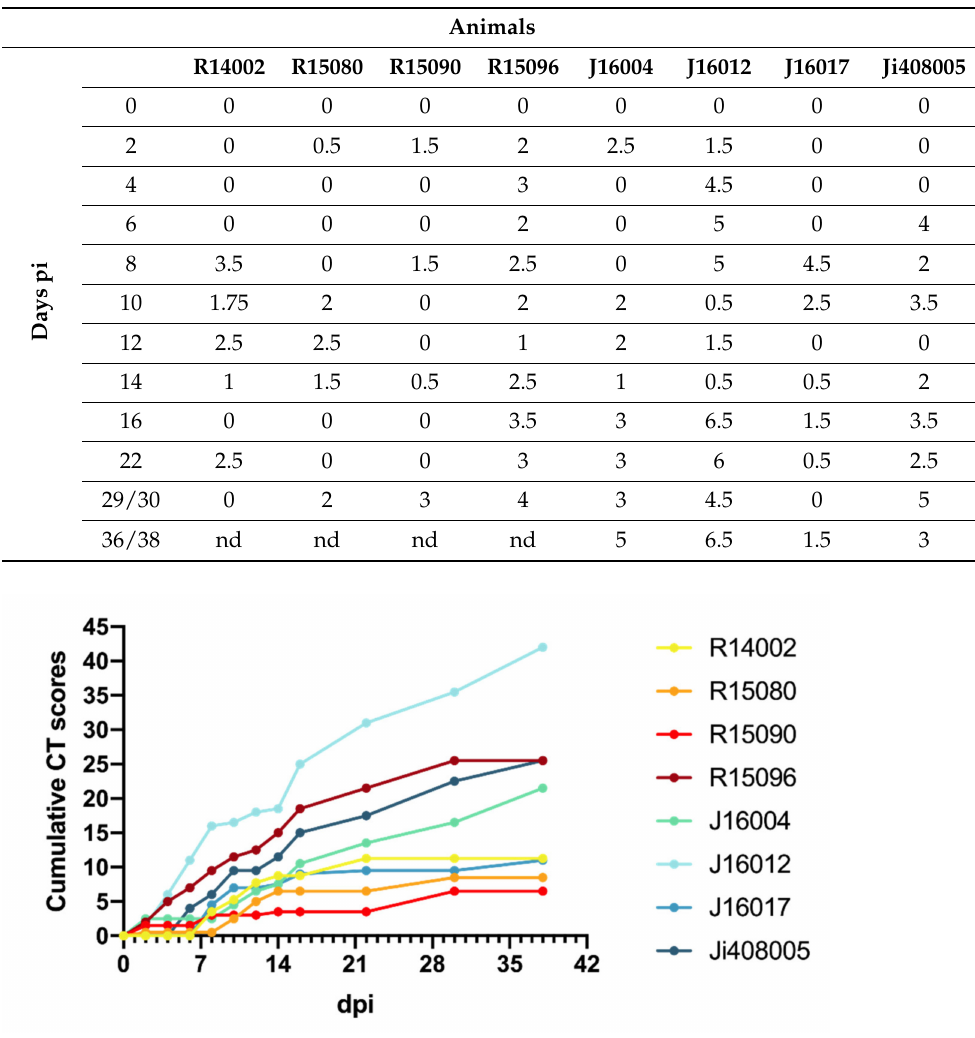
Table 1. CT scores of lung lesions in SARS-CoV-2-infected macaques. Scoring was performed independently by two experienced scientists.